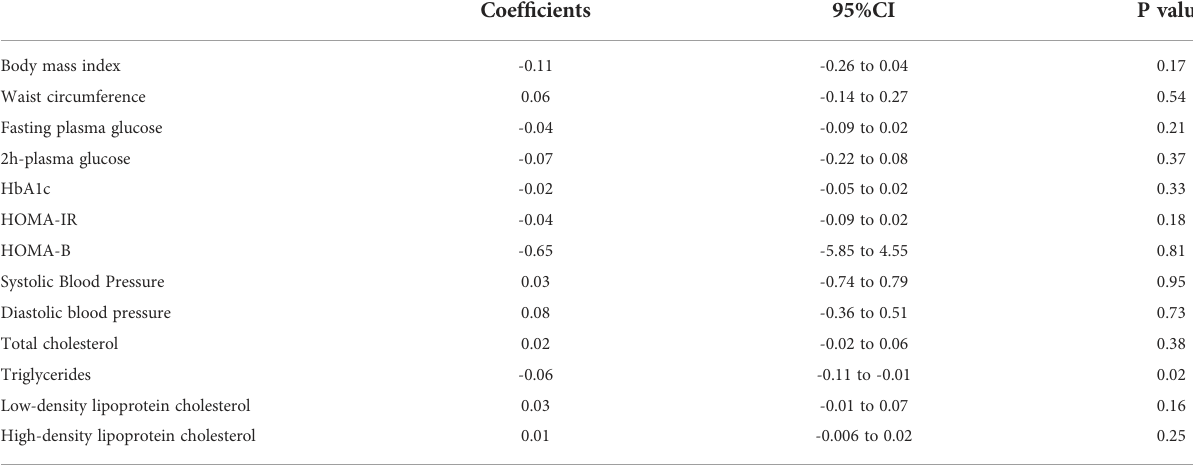
TABLE 2 The association between per SD increment of serum Sparcl1 levels and metabolic measurements.